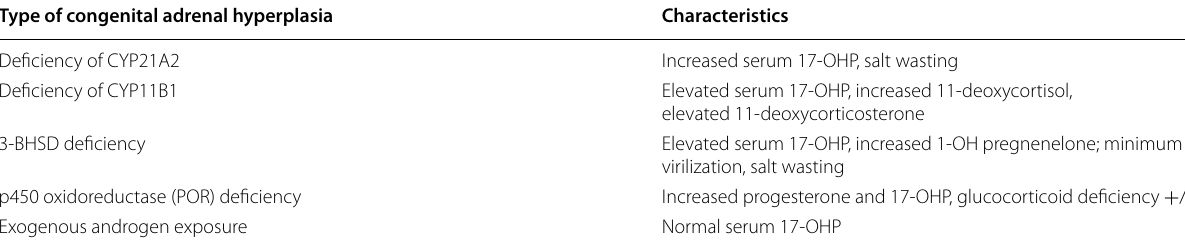
Table 5 The further characterization of 46 XX DSD based on endocrine profile